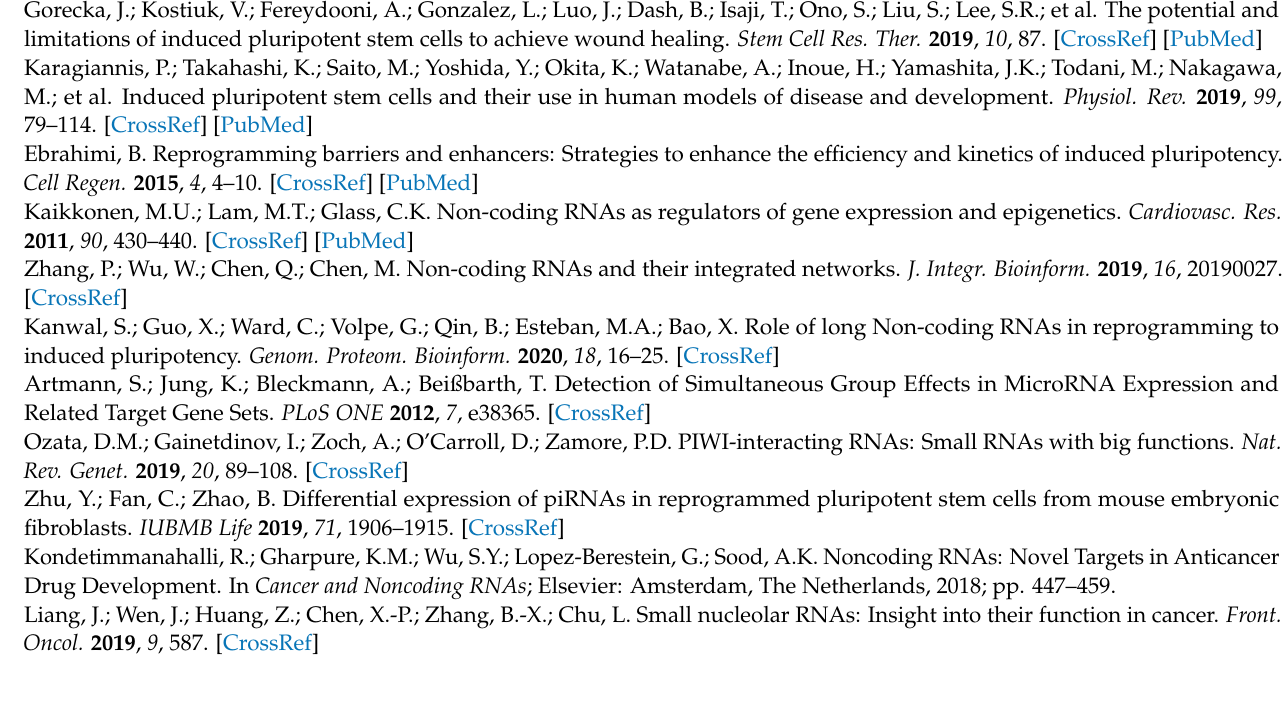
iPSCs vs. Fibroblasts. Table S3: miRNA analysis Fibroblast high reprogramming efficiency vs. normal reprogramming efficiency. Table S4: mRNA analysis Fibroblast high reprogramming efficiency vs. normal reprogramming efficiency. Table S5: miRNA analysis iPSCs high reprogramming efficiency vs. normal reprogramming efficiency. Table S6: mRNA analysis iPSCs high reprogramming efficiency vs. normal reprogramming efficiency. Table S7: miRNA target filter in fibroblasts with high repro- gramming efficiency vs. normal reprogramming efficiency. Table S8: miRNA target filter in iPSCs with high reprogramming efficiency vs. normal reprogramming